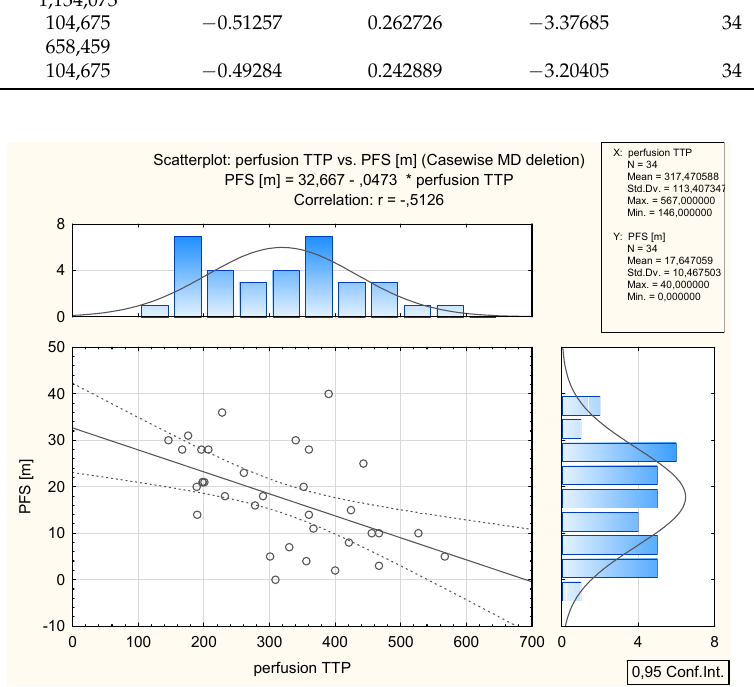
Table 5. Correlations between ADC, Perfusion TTP and Perfusion. Max. En. in primary tumor and PFS. Correlations Marked Correlations are Significant at p < 0.05000 Mean Std.Dv. r(X,Y)